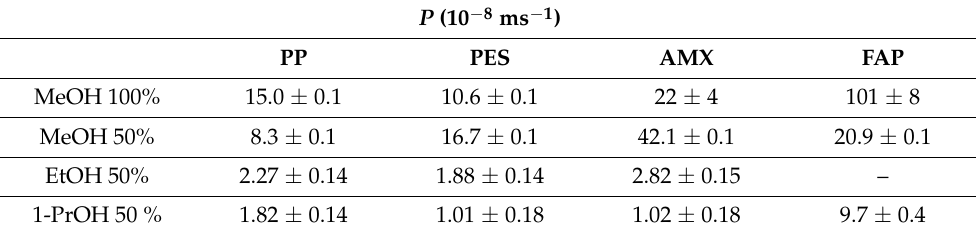
Table 3. Alcohol permeability values for nondoped membranes with 100% and 50% wt. alcohol in the alcohol chamber.